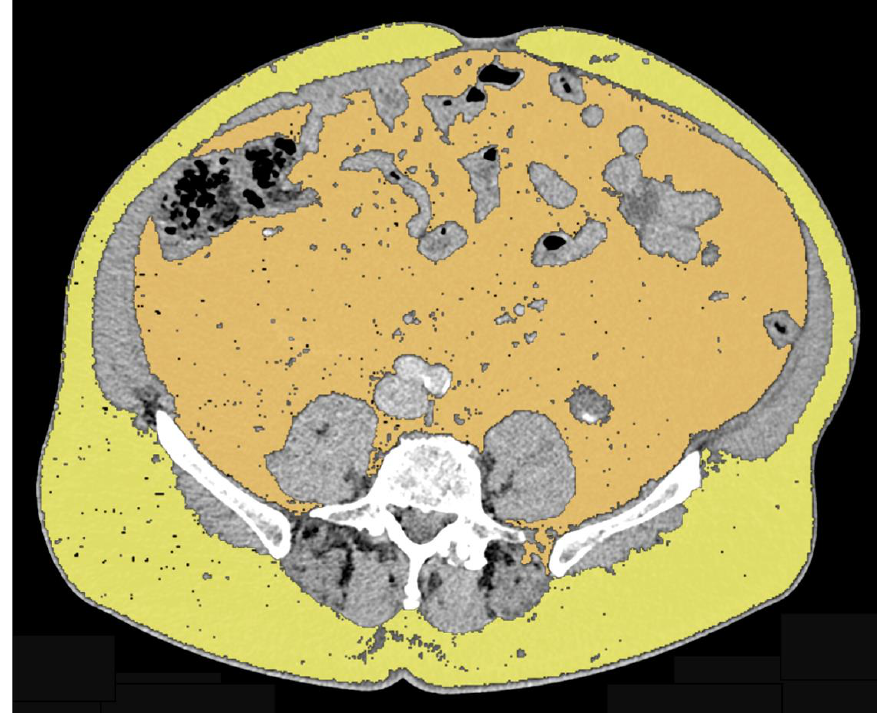
Figure 1. Axial CT image of a male subject showing VAT segmented in orange and SAT segmented in yellow.